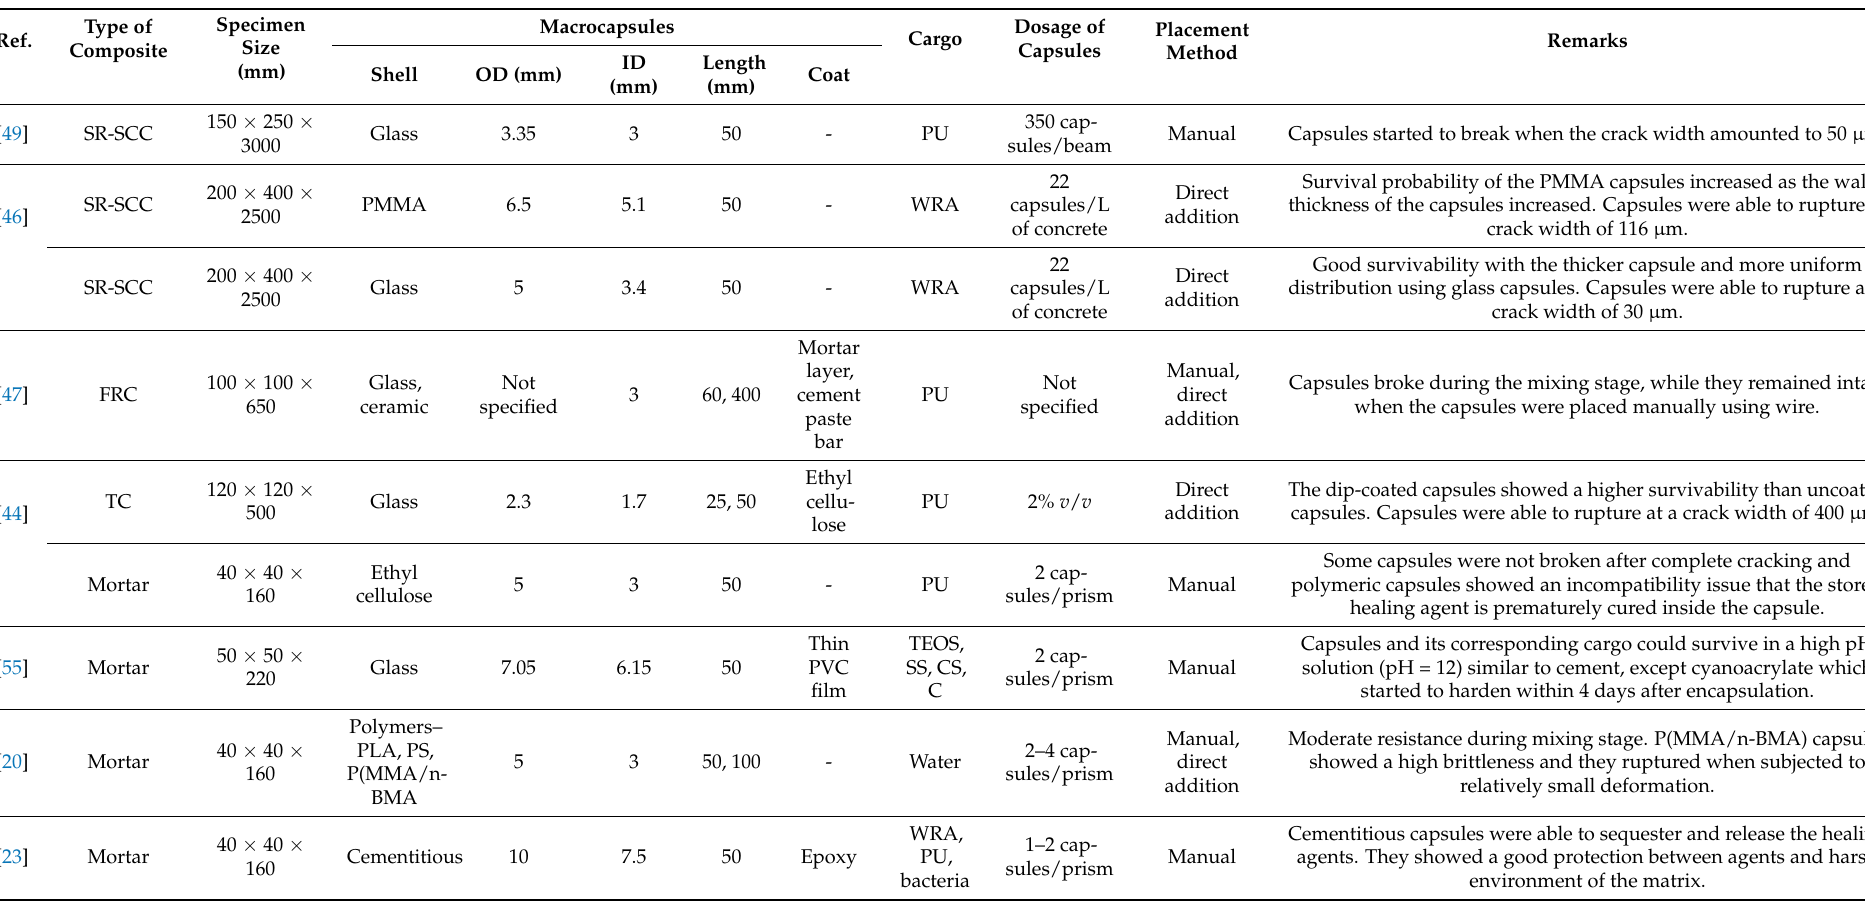
Table 2. Different macrocapsule materials with the corresponding parameters and characteristics used recently in mortar and concrete applications.